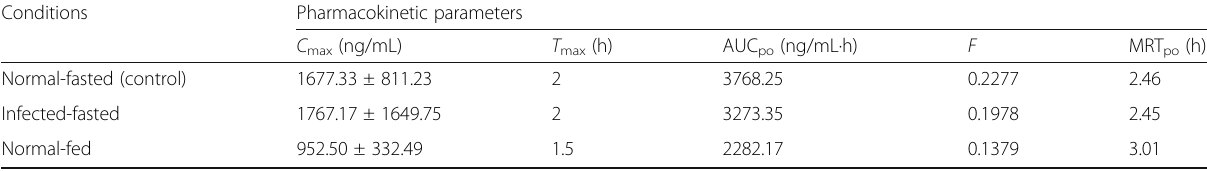
Table 3 Effect of food and parasite infection on the oral absorption of N-251 in